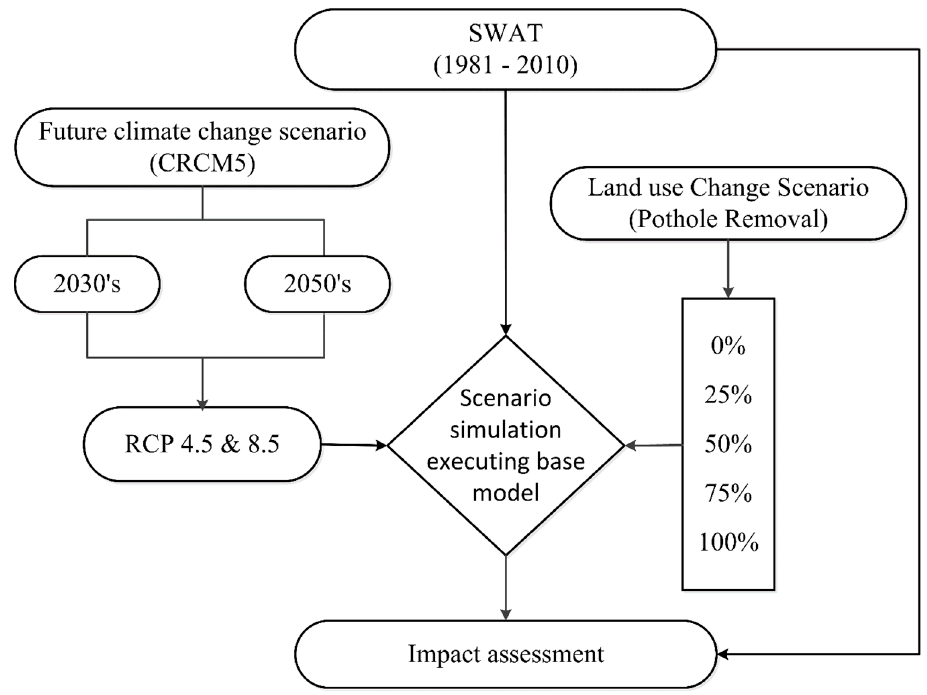
Figure 4. Schematic of climate and land use change scenario workflow.